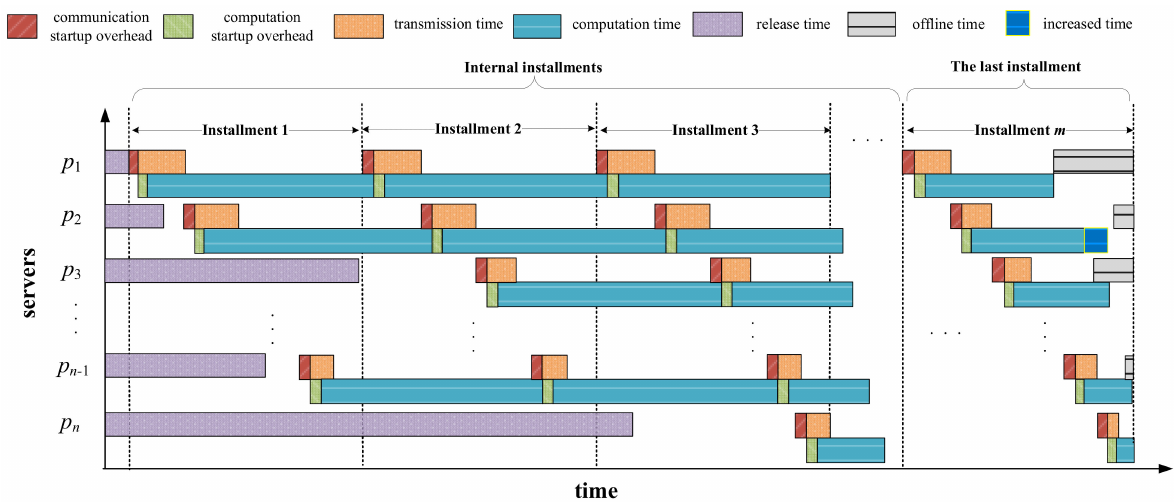
Figure 4. Multi-installment scheduling after applying repair strategy on the first